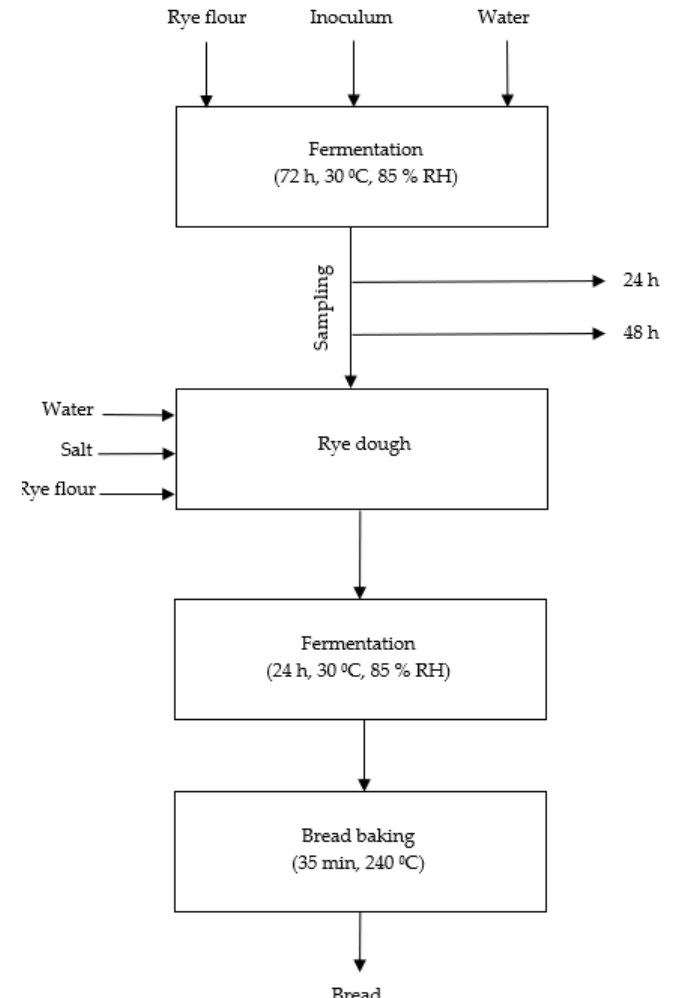
Figure 2. The scheme of the study design.